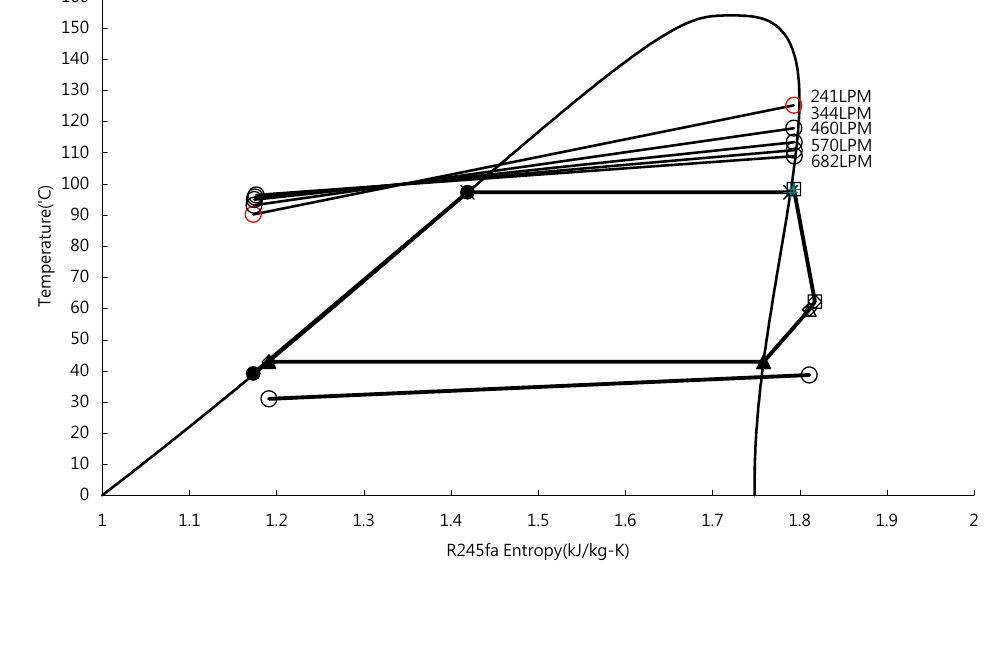
Figure 4. Cycle variation in terms of TS diagram for the present 50kW ORC system subject to change of hot water flowrate in the